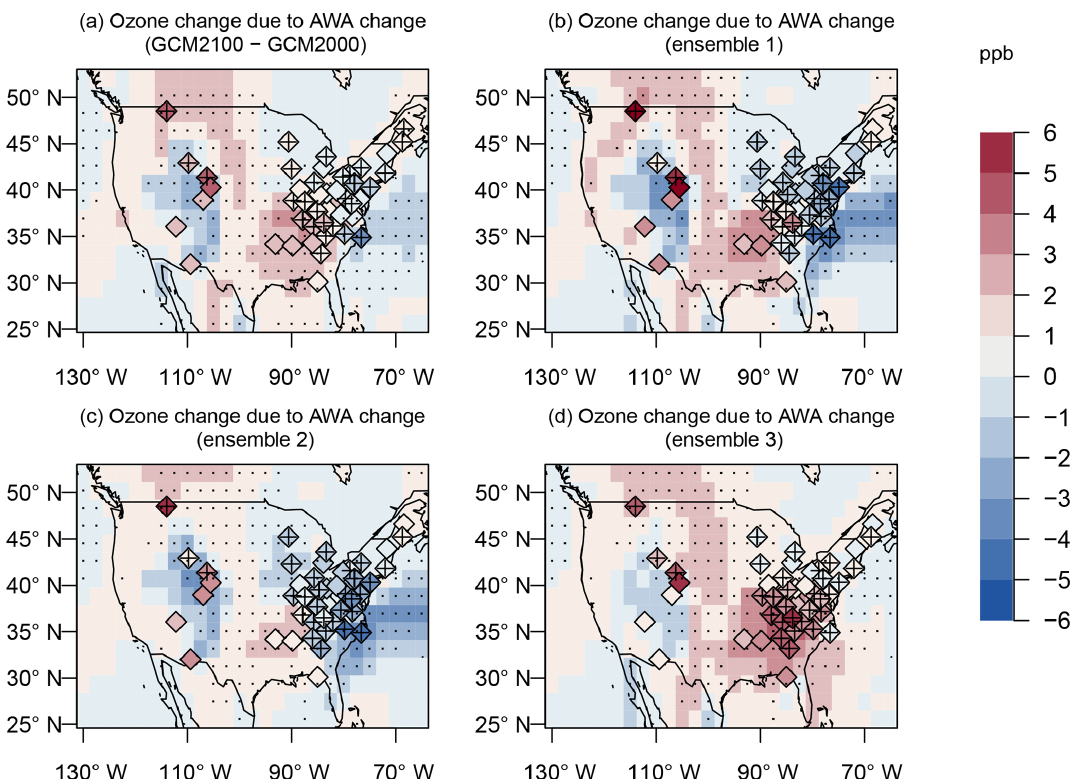
Figure 9. Change in MDA8 ozone from the linear regression model derived from the GCM2000 simulation (shaded) or the measurements (diamonds) using the AWA difference projection as the explanatory variable. Differences in AWA are calculated between the GCM2100 simulation and GCM2000 simulation (a) from the three ensemble members of the REFC2 simulation between 2090 and 2099 and 2000 and 2009 (b–d) . Plus signs and stippling represent where the future change of AWA is significant (at the 5% significance level) at CASTNET sites and model grids,